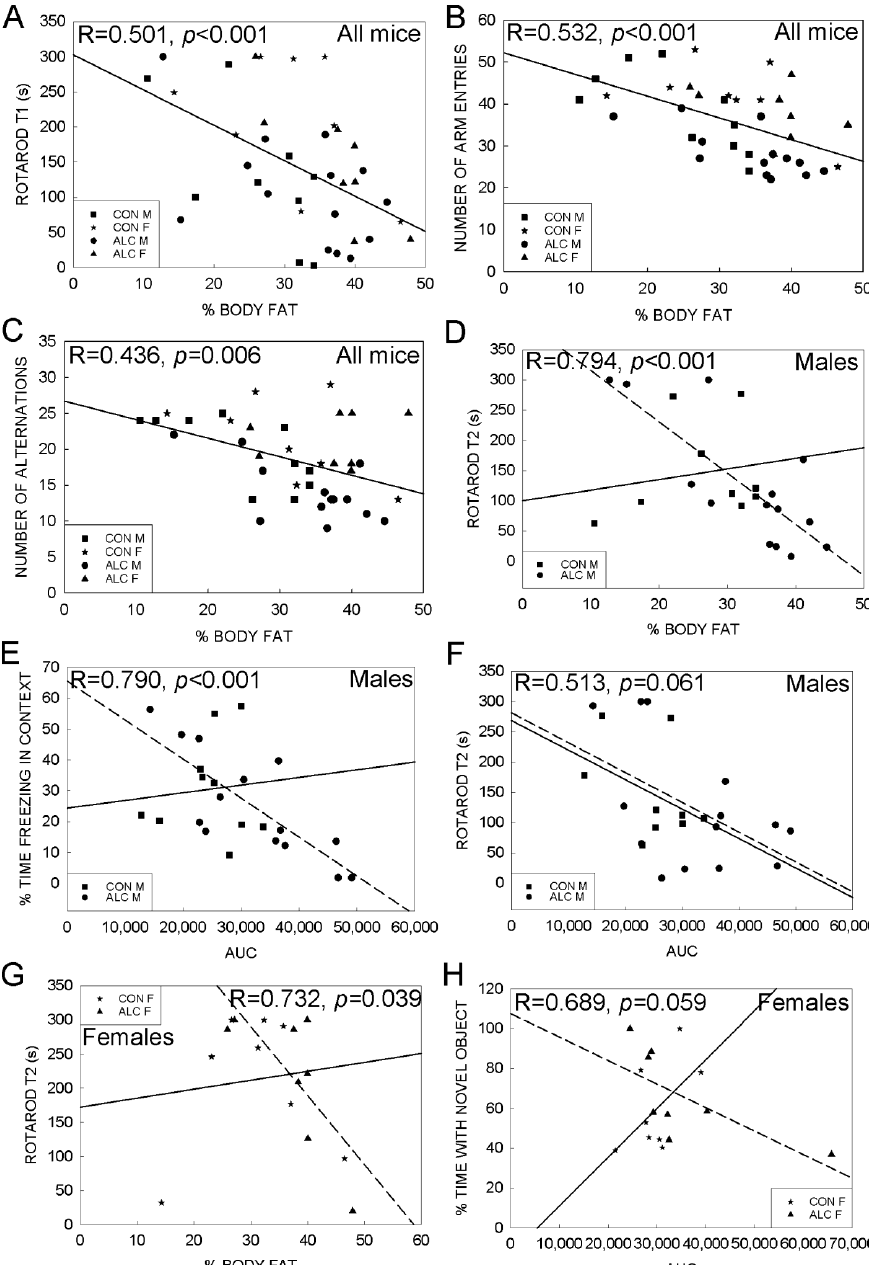
Figure 7. Association analysis between metabolic and behavioral outcomes in 18-month-old ALC and CON mice. ( A ) Regression analysis shows a negative correlation between % fat mass and rotarod training (T1) performance at 17 months in all mice. Correlation between % fat mass and number of arm entries ( B ) and the number of alternations ( C ) in the Y-maze test is also negative for all mice. ( D ) Correlation between % fat mass and rotarod performance at trial 2 (T2) is negative for ALC males but not significant for CON males. ( E ) A negative correlation between AUC and % time freezing in the contextual fear conditioning task is seen in ALC male mice, but not CON males. ( F ) In the rotarod trial (T2), the correlation with AUC is negative for ALC males but not CON males. ( G ) In females, there is a negative correlation between % fat mass and rotarod performance at trial 2 (T2) in ALC mice but not CON. ( H ) There is a trend for a negative correlation between AUC and % time spent with the novel object for ALC female mice but not in CON females. In all panels, symbols indicate values for individual animals. Regression lines for CON are solid and are dashed for ALC. Only regression values that were significant are presented; in ( A – C ) these are for all mice and in ( D – H ) only ALC values are